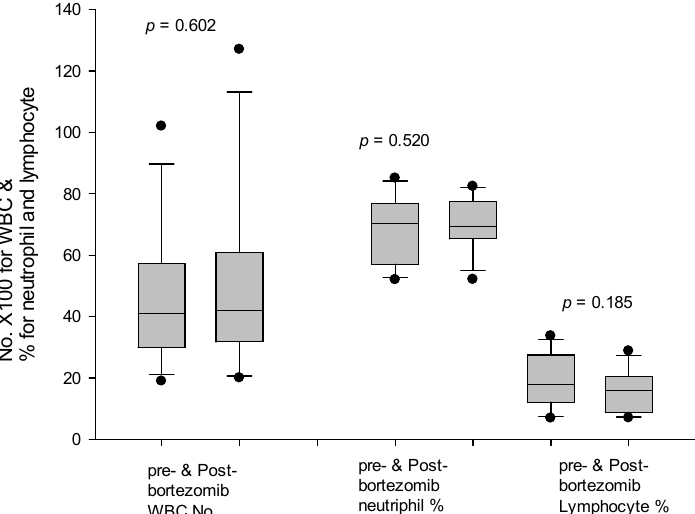
Figure 6. White blood cell count, percentage of neutrophils, and percentage of lymphocytes before and after bortezomib administration. White blood cell count, percentage of neutrophils, and percentage of lymphocytes were not different before and after bortezomib administration.